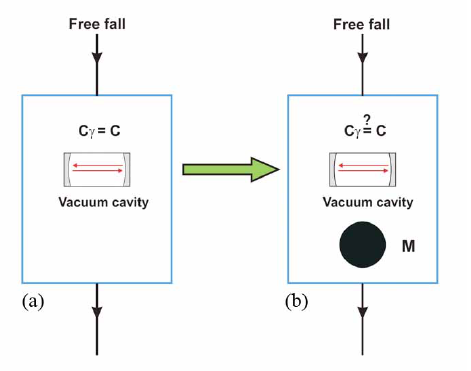
Figure 6. A heavy mass M is carried on board of a freely falling system, case ( b ). With respect to the ideal case ( a ), the mass M modifies the local space–time units and could introduce a vacuum refractive index N v (cid:54) = 1 so that now c γ (cid:54) = c . With a preferred frame, one would then expect off- diagonal elements g 0 i ∼ 2 ( N v − 1 )( v i / c ) in the effective metric, which describes light propagation for the ( b ) reference